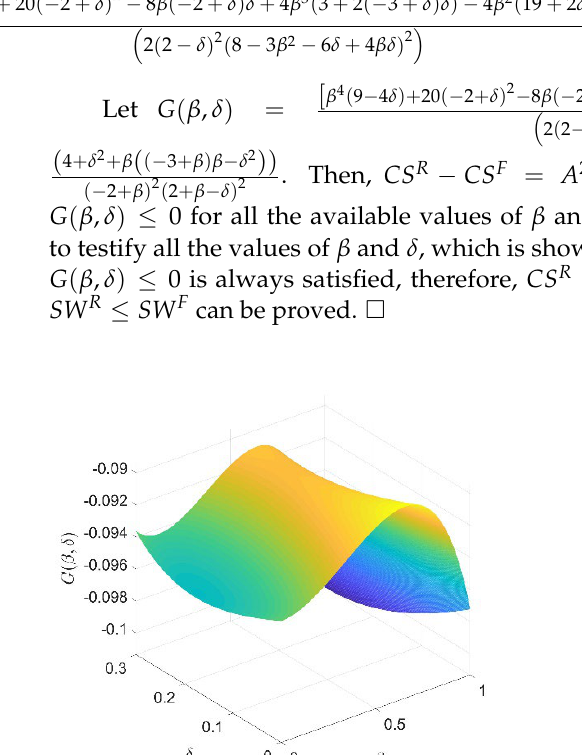
with respect to 𝐺𝐺 ( 𝛽𝛽 , 𝛿𝛿 )